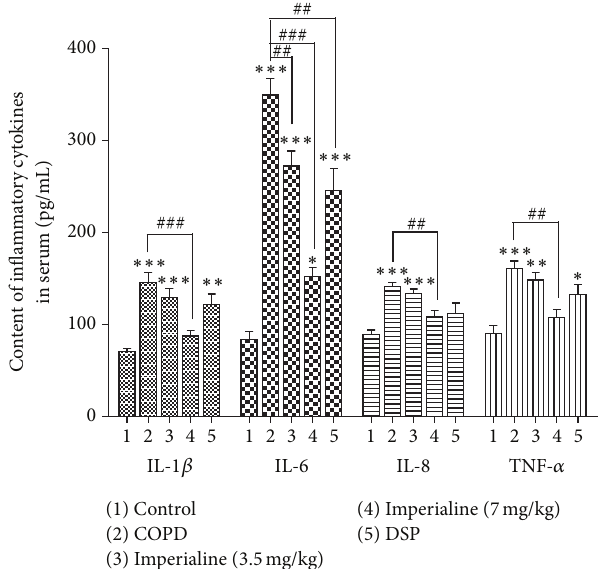
Figure 5: The effect of imperialine on levels of the inflammatory cytokines in serum. Results were expressed as the mean ± SEM ( 𝑛 = 10 ). Significant differences compared with the control group were designated as ∗ 𝑃 < 0.05 , ∗∗ 𝑃 < 0.01 , and ∗∗∗ 𝑃 < 0.001 . Significant differences compared with the COPD group were designated as ## 𝑃 < 0.01 and ### 𝑃 < 0.001 .